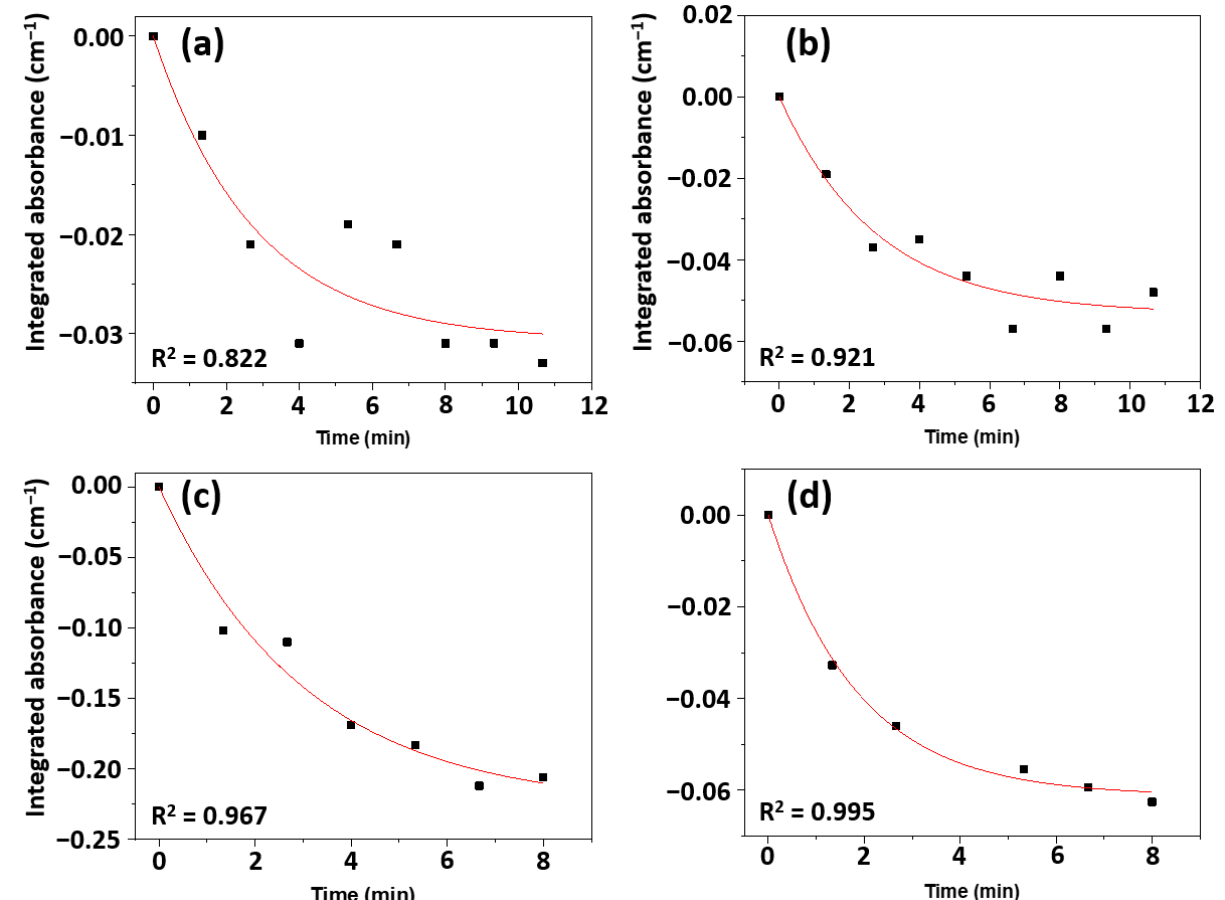
Figure 8. Integrated absorbance for the degradation of carboxylates during UV illumination